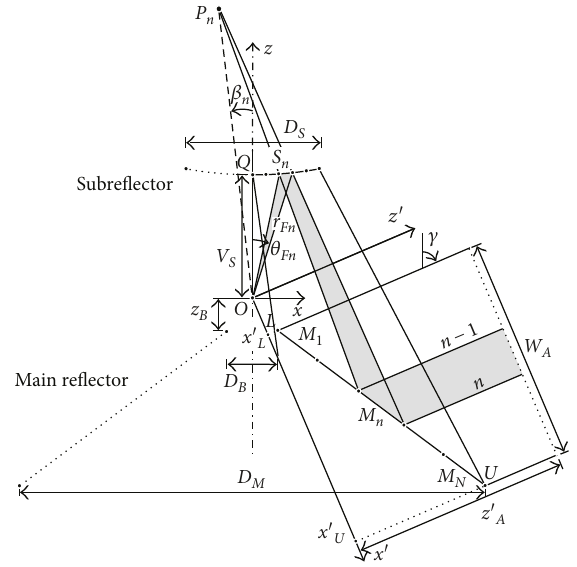
Figure 2: Geometry of the shaped omnidirectional ADC-like